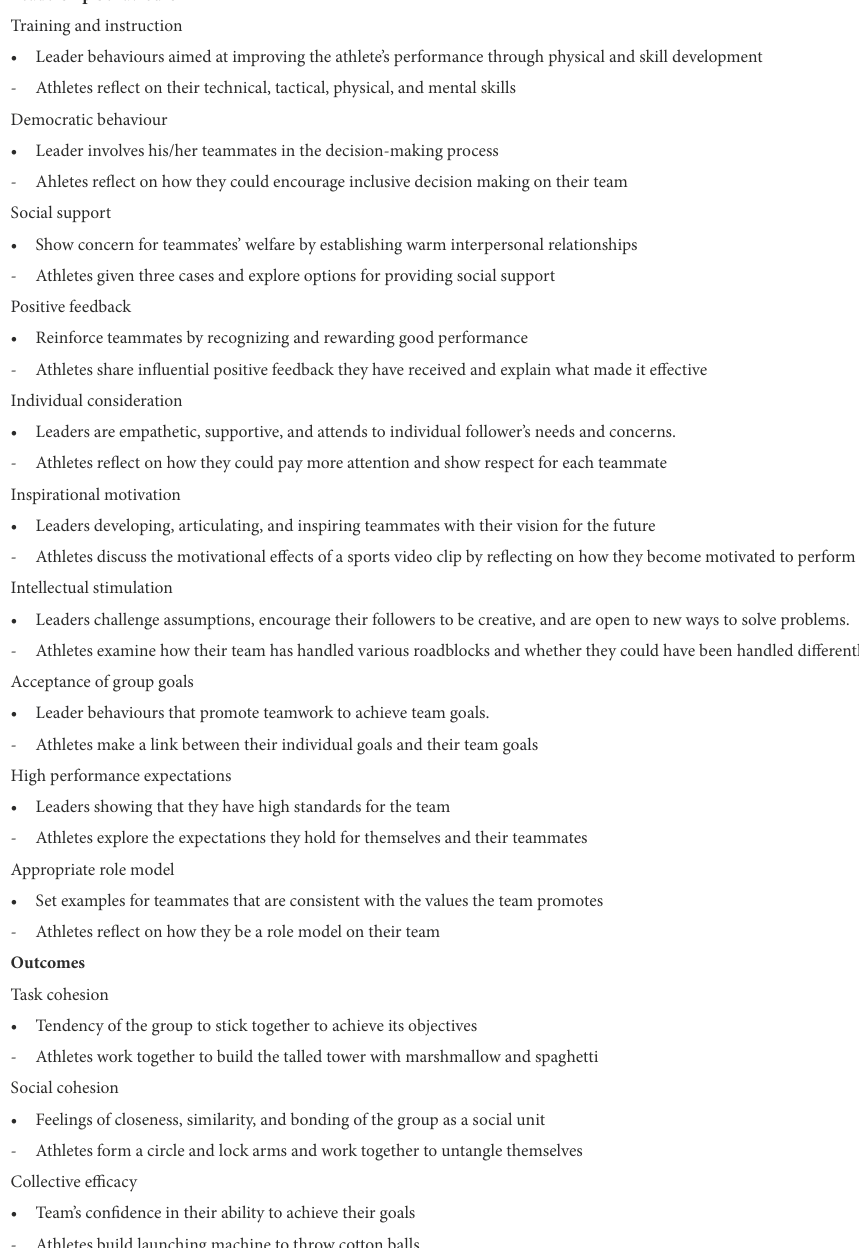
TABLE 2 Workshop behaviours and sample